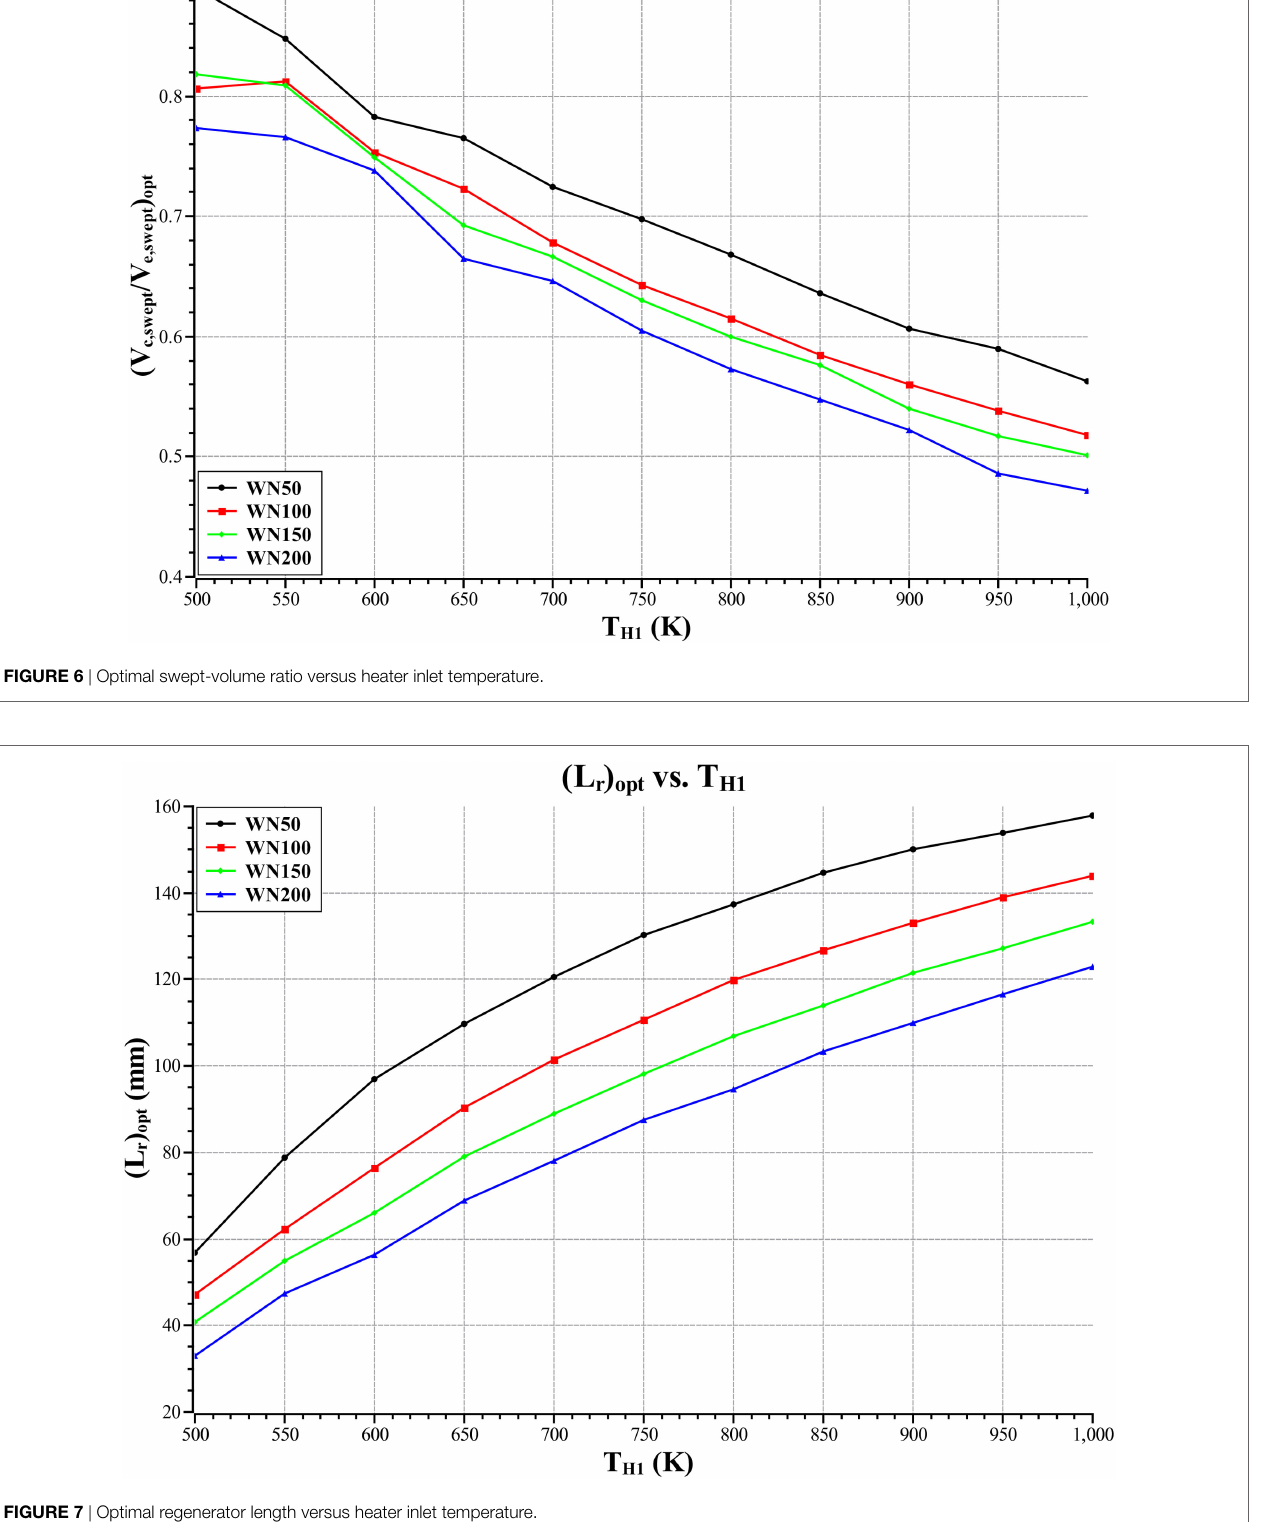
Frontiers in Mechanical Engineering |